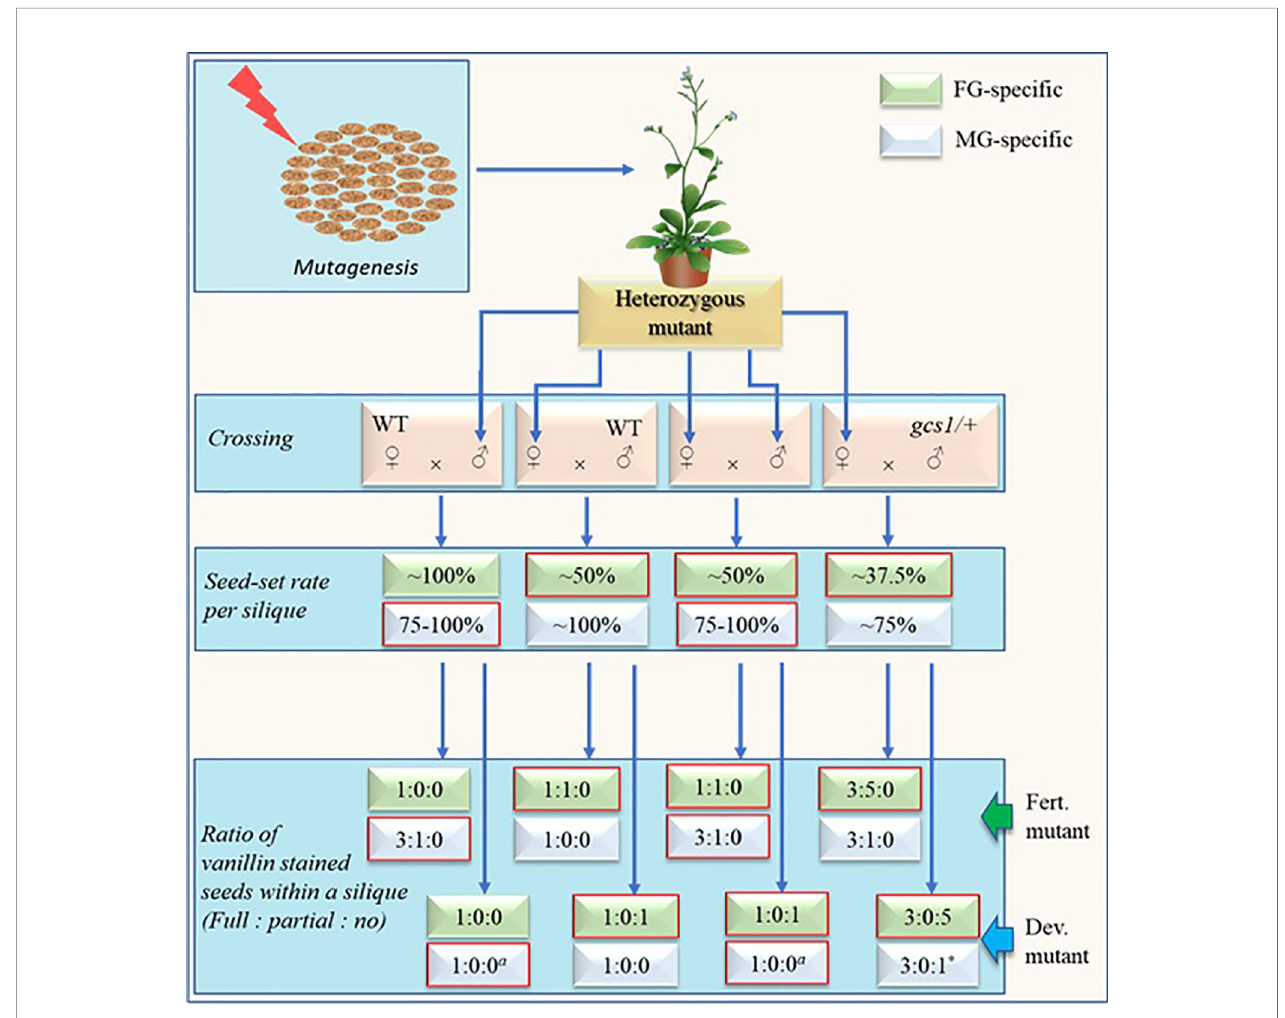
FIGURE 3 | Schematic representation of screening steps (without selection marker assistance) for fully penetrant fertilization defective male or female gametophytic mutants with expected rates and ratios of seed-sets and vanillin staining respectively. Self-cross is suf fi cient for mutant screening via this approach. Other crosses are shown mainly for the comparison purpose. Developmental-defective mutants (dev. Mutants) have defects in the development of either female gametophyte (FG) or vegetative cell of male gametophyte (MG) while fertilization-defective mutants (fert. Mutants) have defects either in FG at fertilization step or MG during the development and/or function of sperm cells (SCs). The seed-setting rate will remain ~75% in SC-defective MG mutants while it may increase to near 100% in vegetative-cell-defective mutants. The numerical fi gures represent the theoretically possible maximum values determined largely based on the studies by Kasahara et al. (2012) and Liu et al. (2020). Expected rates and ratios for respective mutants are in boxes with red margin. a = The values depend on the degree by which the stigma is saturated with pollens. The displayed values represent the case when the stigma is excessively pollinated. Upon limited pollination, the number of full/ partial-stained ovules may decrease while that of unstained ovules may increase. * = The value will remain true only when the pollen donor MG mutant is defective in pollen development, pollen tube (PT) growth and/or PT-burst at the ovule instead of SC-defective gcs1/+